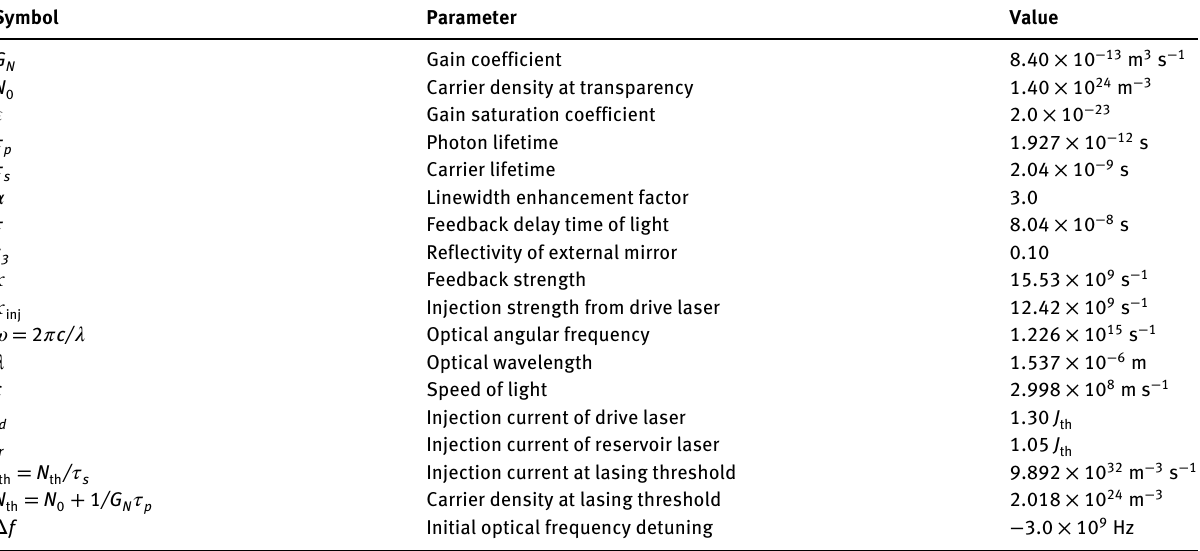
Table 1: Parameter values of the reservoir laser used in numerical simulations.